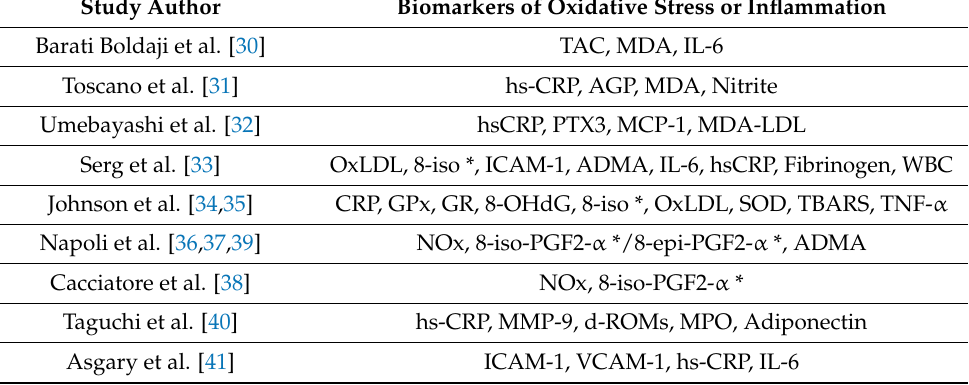
Table 2. Biomarkers that have been tested to determine the antioxidant and/or anti-inflammatory properties of a